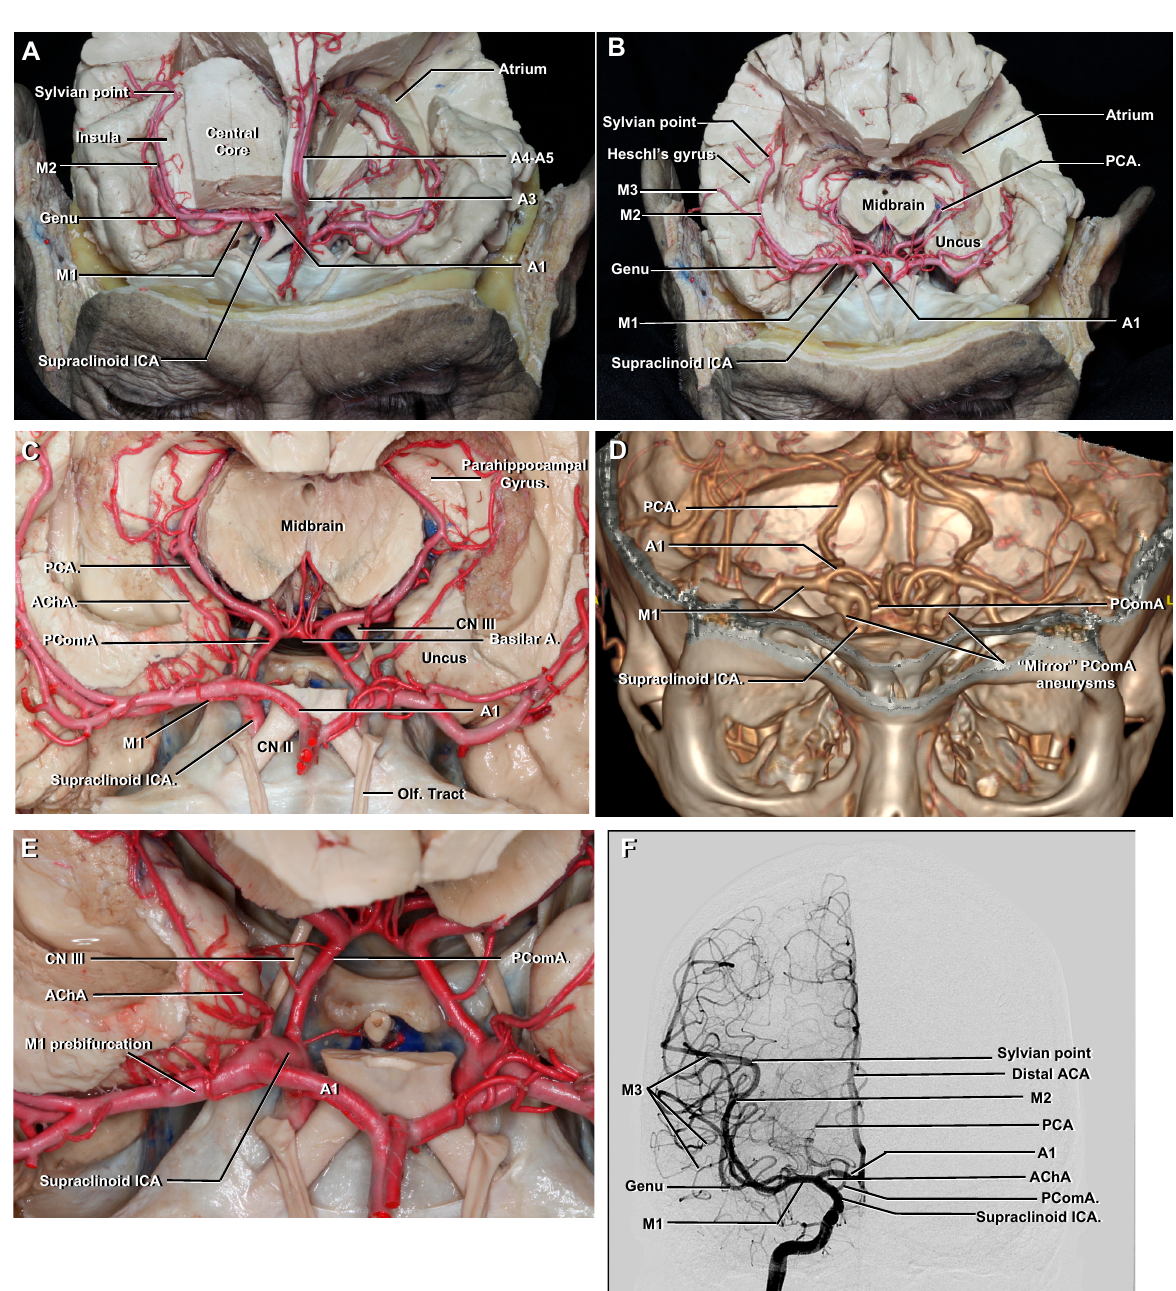
Figure 5. ( A ) Anteroposterior view. The supraclinoid ICA and its terminal branches are clearly seen. M1 originates at the ICA terminal bifurcation, courses with a horizontal trajectory and ends at the genu. M2 begins at the genu and courses with an anterior to posterior trajectory along the insular cortex. A1 courses with a horizontal trajectory to join the AComA. ( B ) The central core has been removed to demonstrate the arterial structures related to the mesial temporal lobe. ( C ) Enlarged view. The uncus and parahippocampal gyrus are limited medially by the PCA. ( D ) Coronal CTA VR reconstruction to be correlated with ( A , C ). Bilateral PComA aneurysms (“mirror aneurysms”) are seen arising immediately distal to the origin of the PComA, and they project posterolaterally towards the oculomotor nerve. ( E ) Enlarged view from ( C ). The AChA originates from the posterior surface of the ICA distal to the PComA, but proximal to the ICA bifurcation, and is closely related to the uncus. ( F ) Anteroposterior view of a right ICA angiogram to be correlated with ( A , C ). The central core of the cerebral hemisphere is located in the rectangle limited anteriorly by the A1, M1 and genu of the MCA, medially by the distal anterior cerebral artery (A2–A5 segments), laterally by the M2 segment and posteriorly by a transverse line drawn from the sylvian point.